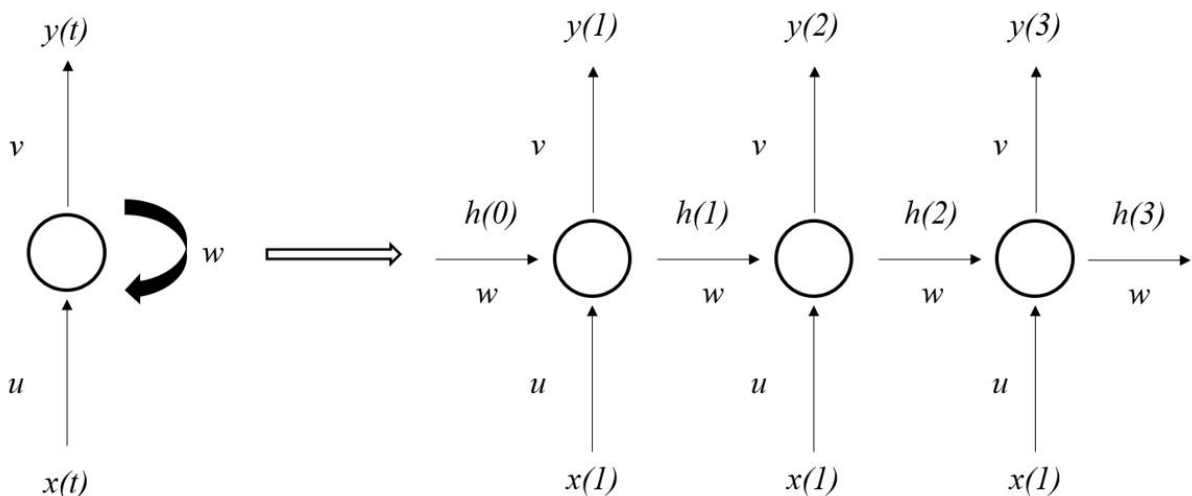
Figure 11. Schematic view of recurrent neural network (RNN) model. In graph, arrow on left side indicates neurons of CNN; x ( t ) and y ( t ) are put as an input and output step respectively. The right-side graph shows the RNN expansion architecture. Respectively, u , v and w are the weight matrices corresponding to the input, output and hidden states. The same time states share one weight matrix, which greatly reduces the number of parameters in the model to be learned.